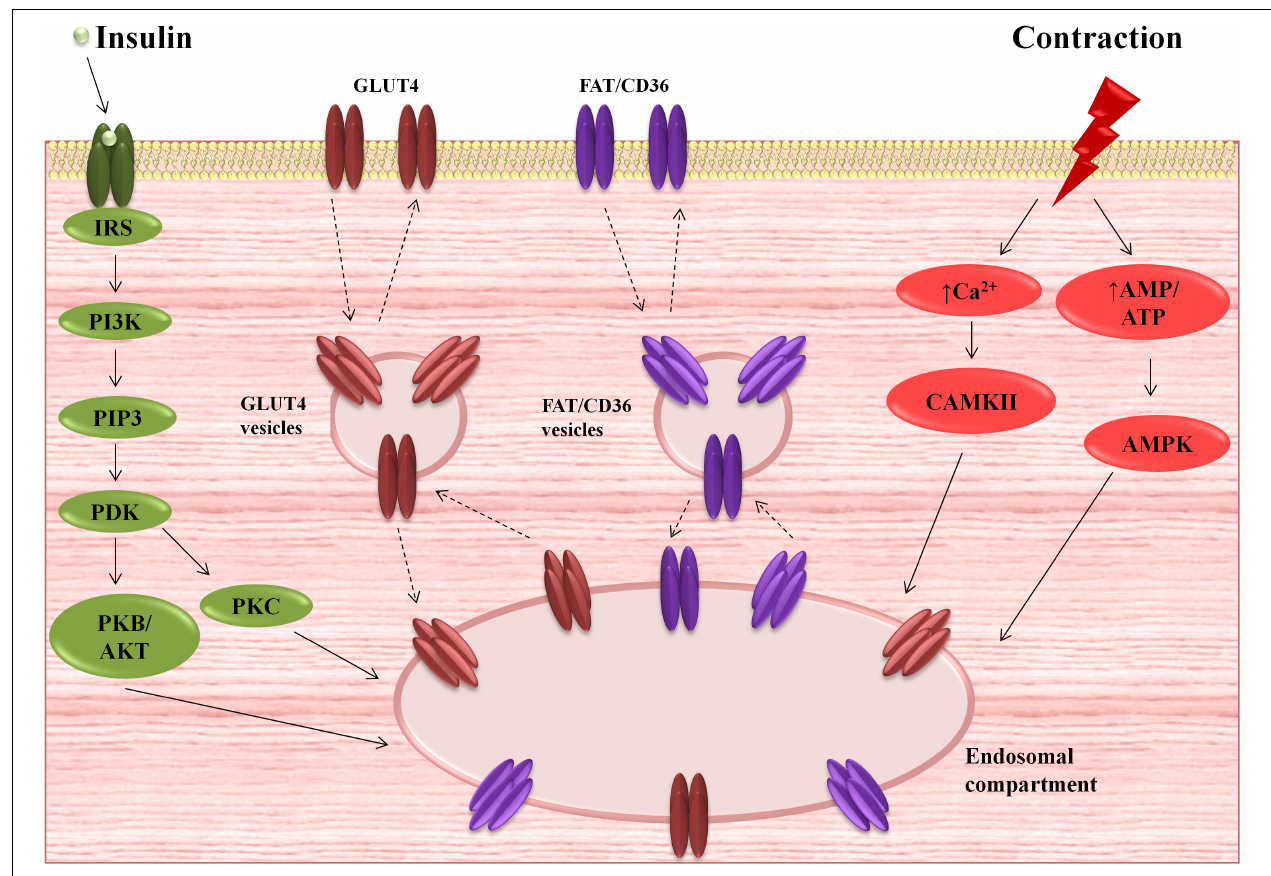
FIGURE 1 | Myocardial activation of insulin and contractile signaling pathways and subsequent translocation of glucose transporter 4 (GLUT4) and fatty acid translocase (FAT/CD36) from the intracellular compartments to the plasma membrane (PM). AMPK, AMP-activated protein kinase; CAMKII, Ca 2 + / calmodulin-dependent kinase II; IRS, insulin-receptor substrate; PDK, phosphoinositide-dependent kinase; PI3K, phosphatidylinositol 3-kinase; PIP3, phosphatidylinositol 3-phosphates; PKB/AKT, serine/threonine protein kinase B; PKC, protein kinase